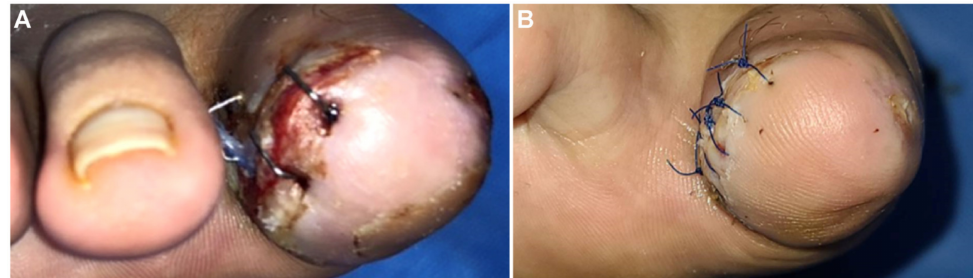
Figure 1. ( A ) Postoperative skin necrosis after interphalangeal joint disarticulation of right first toe (7 days after disarticulation). On the lateral side of the right first toe, skin necrosis with dehiscence occurred, and wound healing was delayed; ( B ) The skin was well epithelialized without any complica- tion after debridement and wound repair with proper medication, smoking cessation, and persistent aseptic dressing with local oxygenation therapy (8 days after debridement and wound repair).